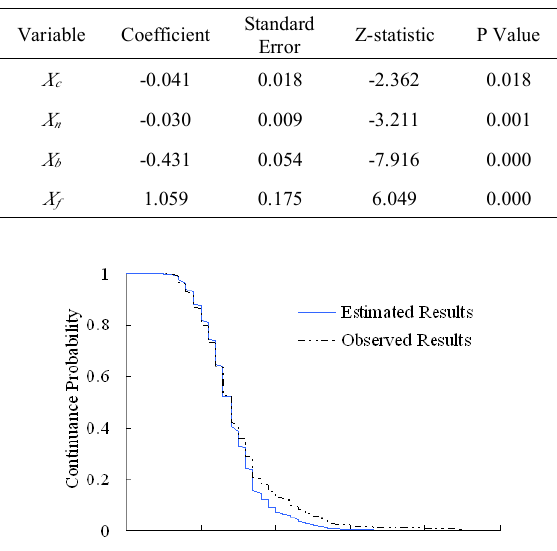
Table 1. Model estimation.